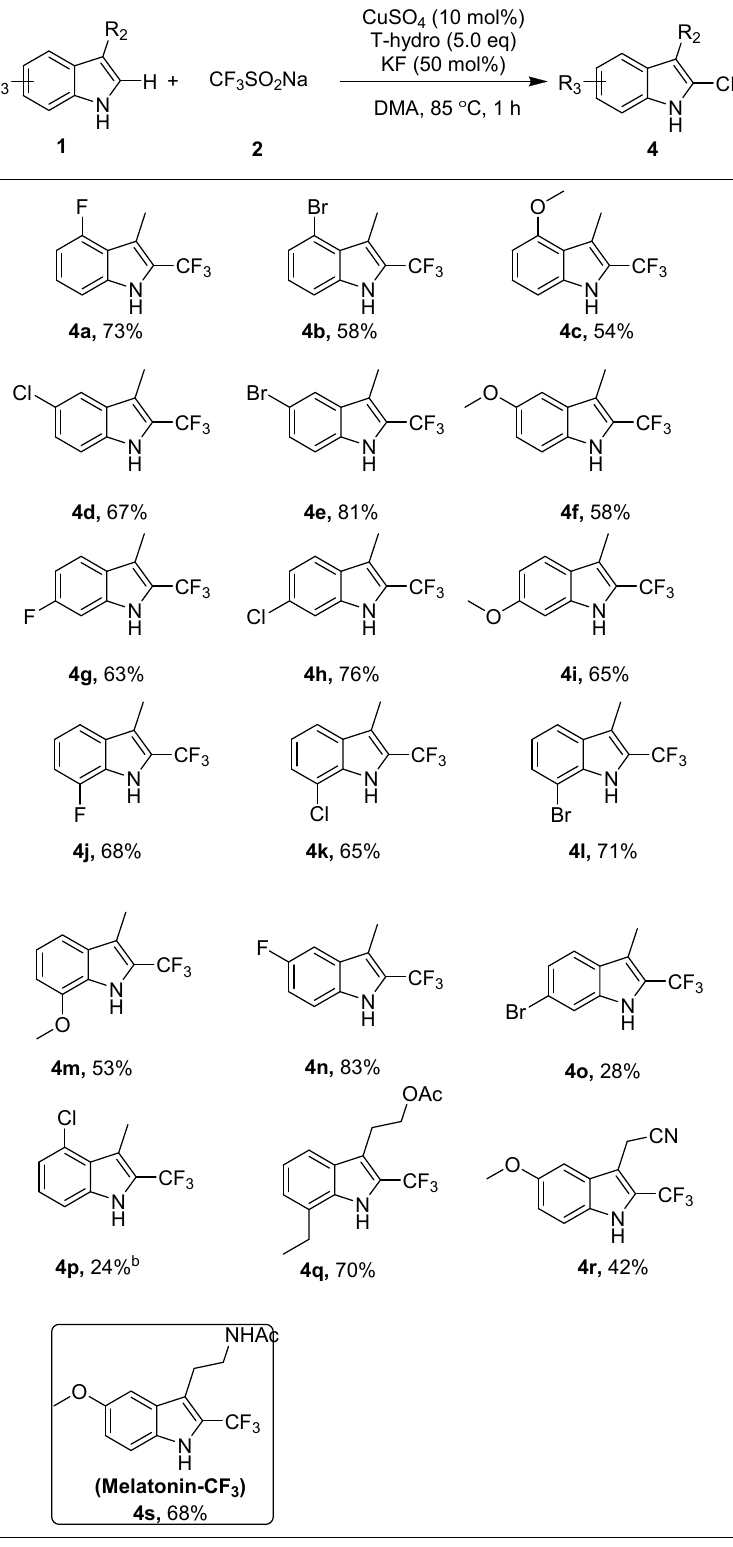
Figure 2. Reaction scope of functional indoles a . a Conditions: 1 (0.5 mmol), 2 (1.5 mmol), CuSO 4 (10 mol %), t BuOOH (2.5 mmol), KF (50 mol%), dimethylacetamide (DMA) (3.0 mL), 85 °C, 1 h, under Ar. Isolated yield. b Yield based on 1 H NMR.